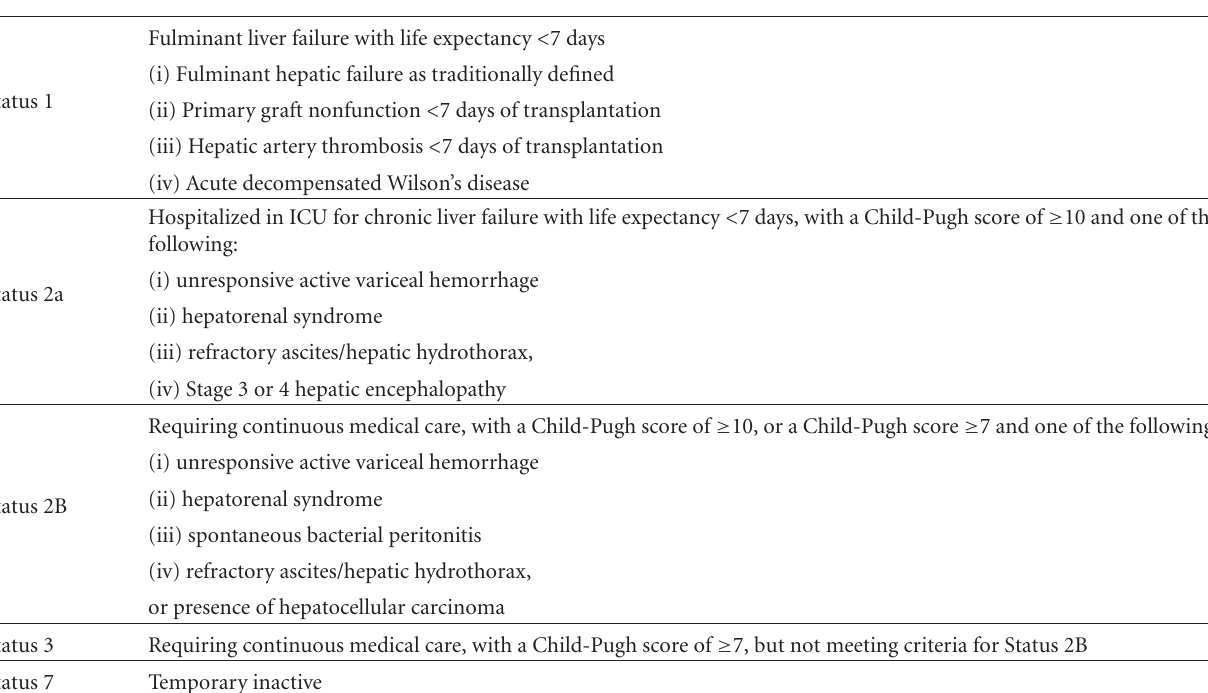
Table 1: United network for organ-sharing (UNOS) liver status